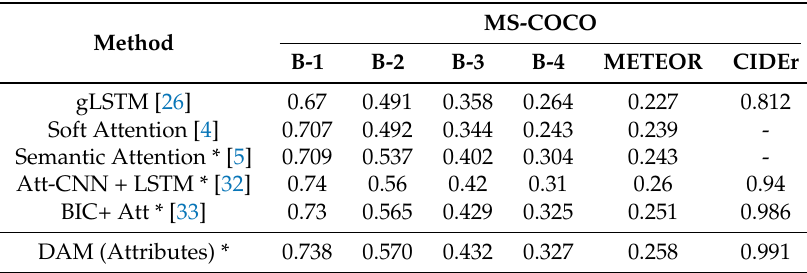
Table 1. Comparisons with recent image captioning methods. “*” stands for the attributes used in the method. gLSTM, guidance LSTM; DAM, dual attention